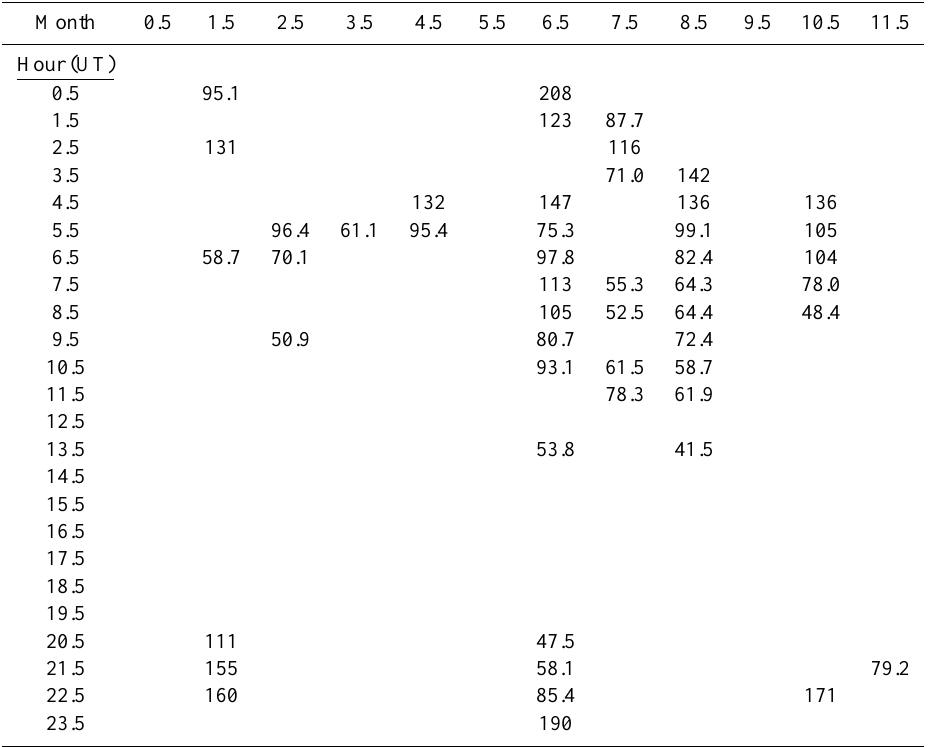
Table A2. Median Electron density at 95km for 1dB absorption